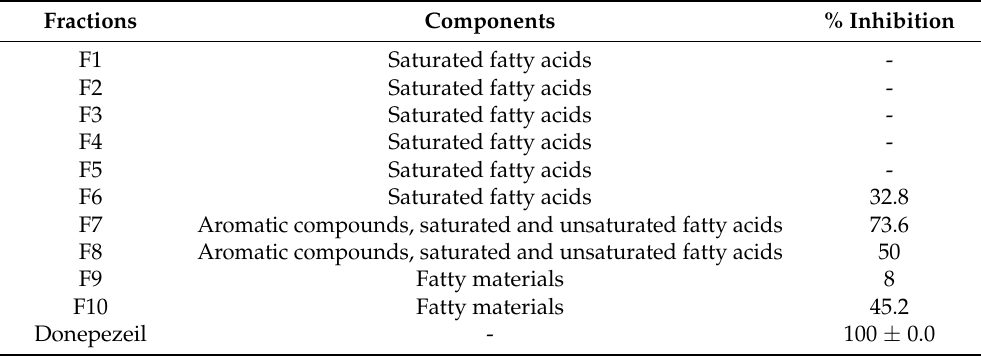
Table 4. The chemical constituents of different fractions of A . variabilis extract and their corresponding effect on AChE activity.